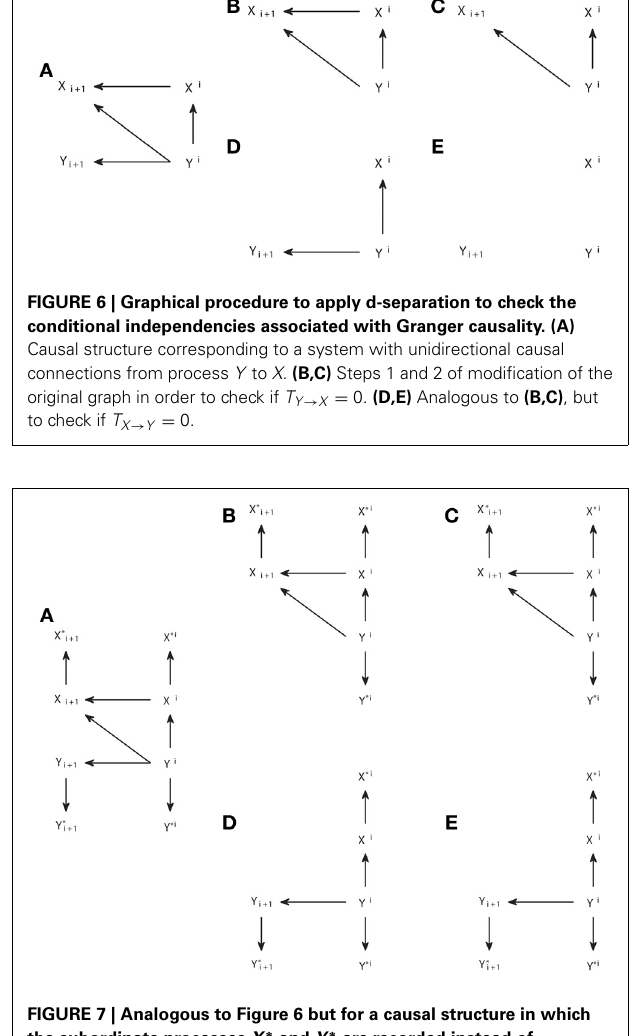
FIGURE 7 | Analogous to Figure 6 but for a causal structure in which the subordinate processes X ∗ and Y ∗ are recorded instead of processes X and Y between which the causal interactions occur. (A) The original causal structure. (B,C) Steps 1 and 2 of modification in order to check if T Y → X = 0. (D,E) analogous to (B,C) , but to check if T X → Y =